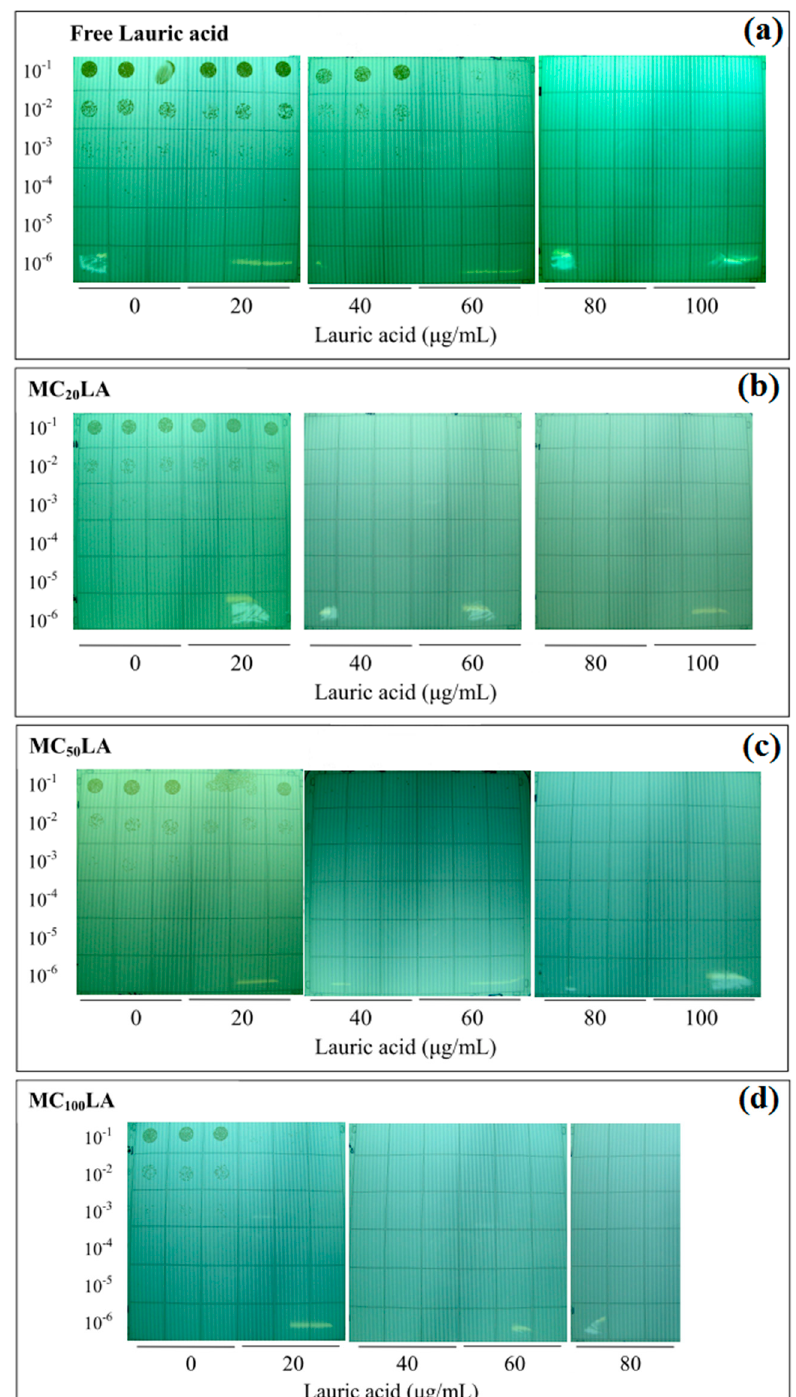
Figure 8. P. acnes grown on RCM in the presence of free LA ( a ) and LA-loaded micelles ( b – d ). The images were photographed with a digital camera. For each type of micelle, three columns ( n = 3) of the bacterial colony were tested. The Y axis indicates the concentration of P. acnes.